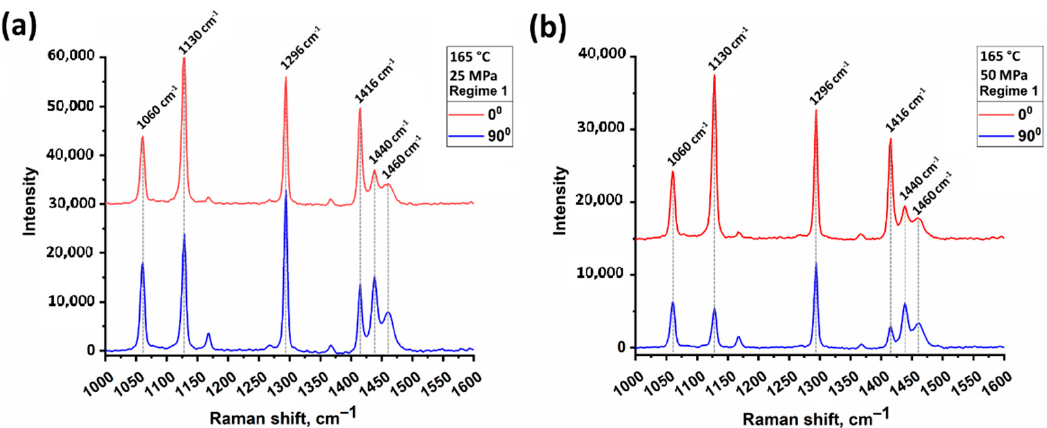
Figure 13. Raman spectra of SRCs obtained at 165 °C and 25 MPa ( a ) or 50 MPa ( b ) (Regime 1) at 0° (red) and 90°C (blue) between the SRC axis and initial beam polarization.